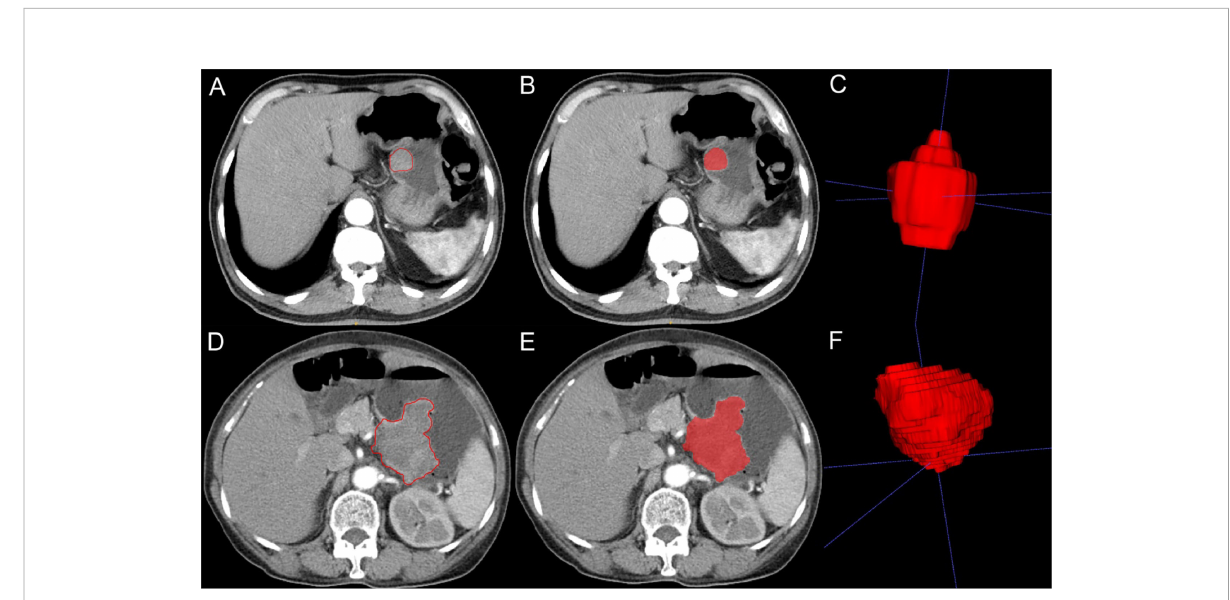
FIGURE 2 Imaging segmentation of gastrointestinal stromal tumors (GIST) on computed tomography (CT) imaging. (A) Two-dimensional (2D) CT arterial phase image of potential malignant GIST. The tumor is quasicircular and uniformly enhanced. The red outline is the boundary drawn by radiologists to show the tumor. (B) 2D segmentation of the tumor. (C) 3D segmentation of the tumor lesion. (D) 2D CT arterial phase image of malignant GIST with irregular shape and uneven internal enhancement of the tumor. The red outline is the boundary drawn by radiologists to show the tumor lesion. (E) 2D segmentation of the tumor. (F) 3D segmentation of the